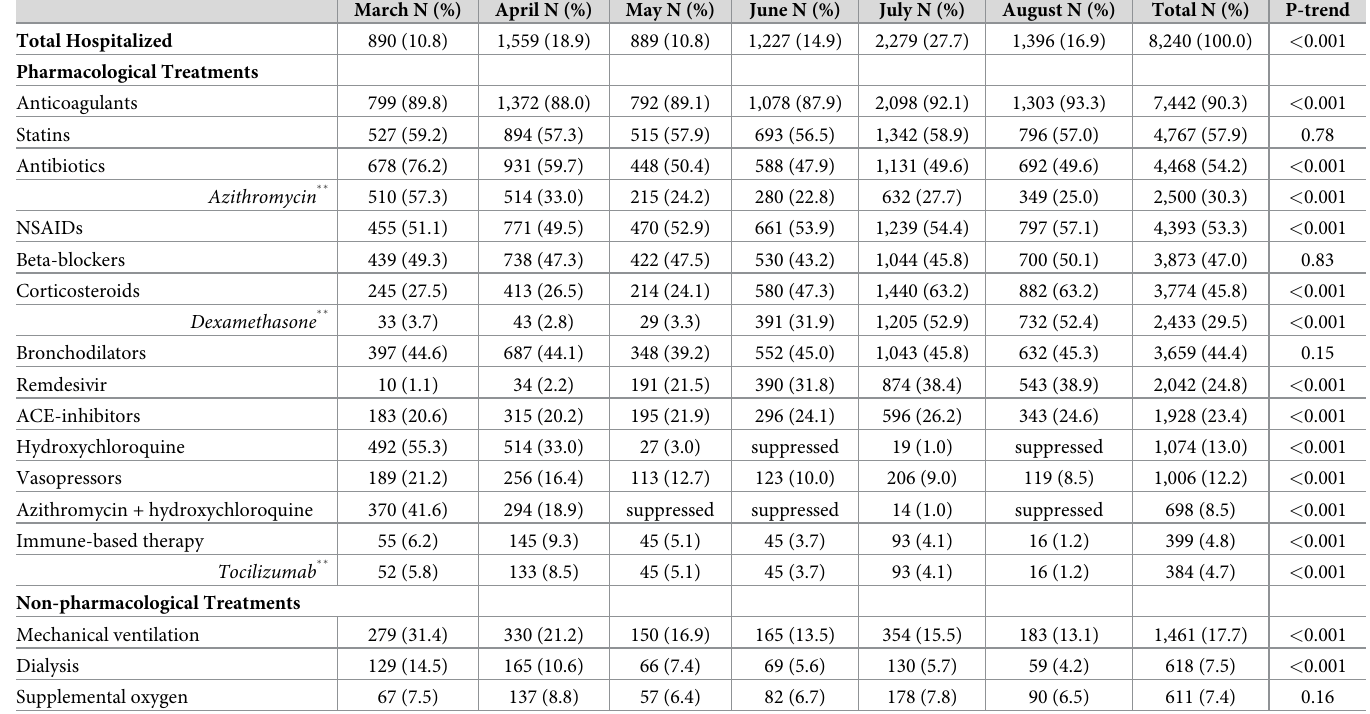
Table 5. Pharmacological and non-pharmacological treatment � among 8,240 hospitalized Veterans Health Administration users with coronavirus disease 2019 (COVID-19), March 1, 2020 –August 31,